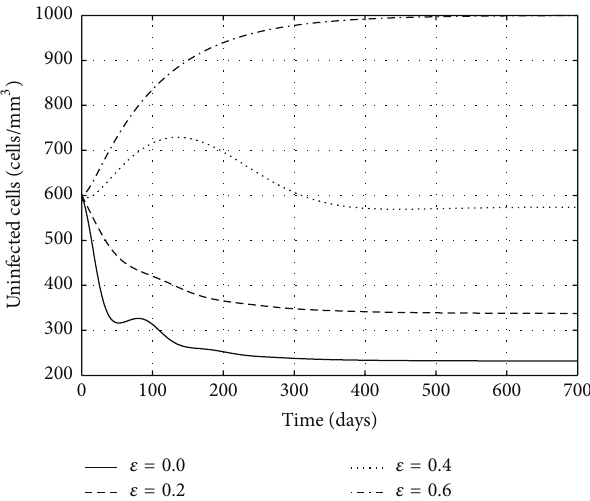
Figure 5: The concentration of B cells for model (104).